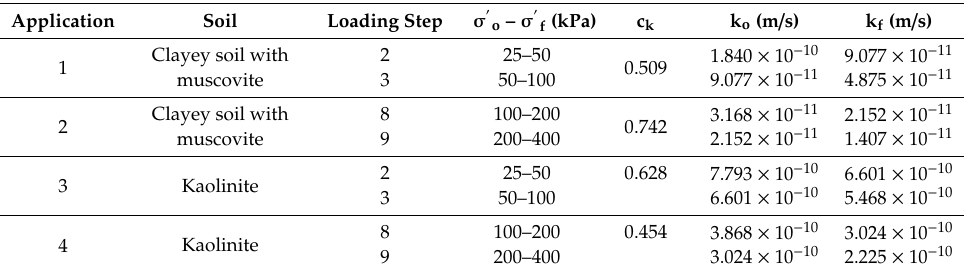
Table 12. Results of c k and k o of each application.